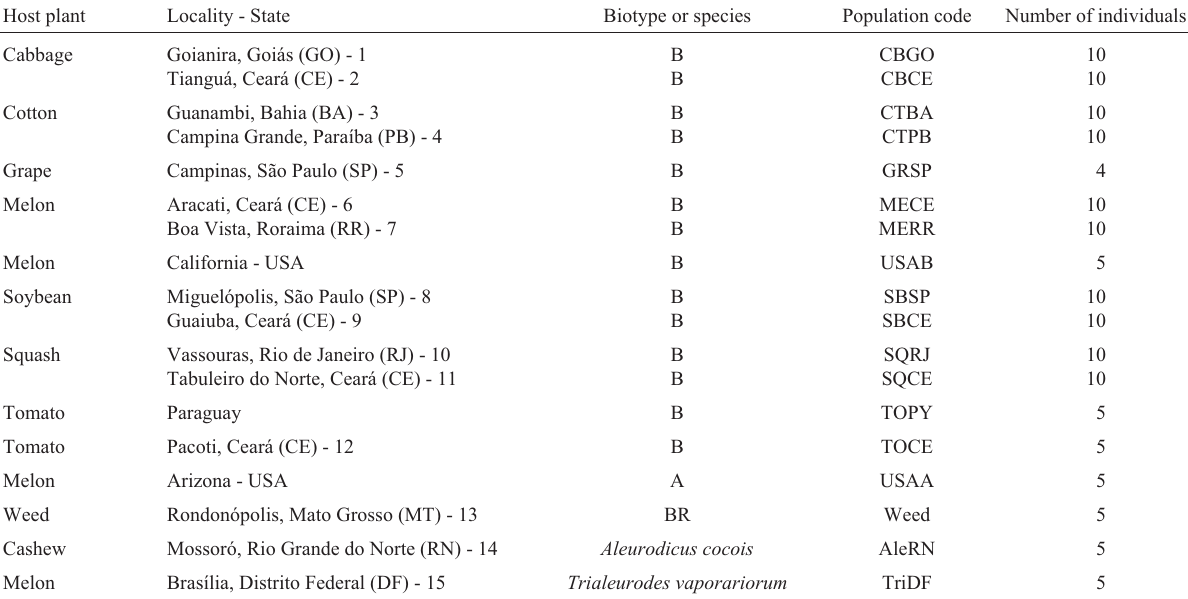
Table I - Host plants, sites where whitefly populations were collected, B. tabaci biotypes (or insect species) population codes used in the analyses and number of individuals analyzed per population. Numbers following the localities correspond to the numbers indicated in the map (Figure 1). Host plant Locality - State